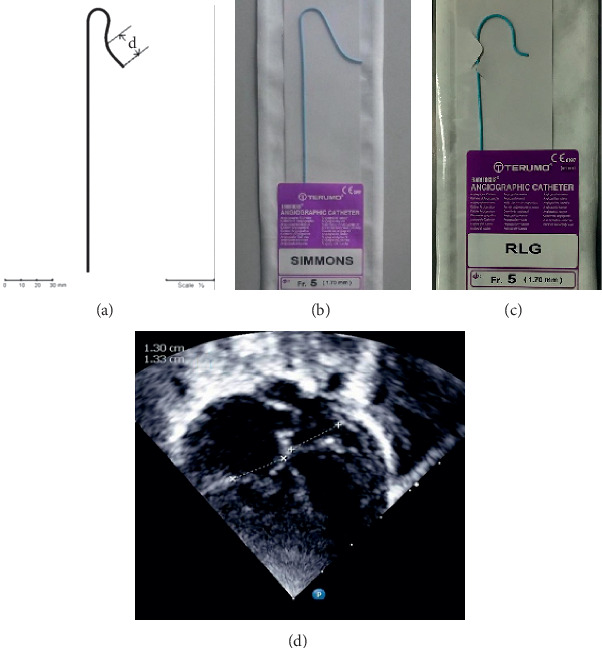
(a) The morphological structure of the Simmons catheter and its distal part. A close-up view of the (b) Simmons catheter and (c) RLG catheter. (d) The measurement of the TV.